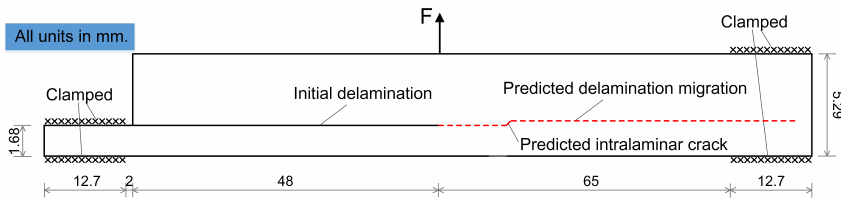
Figure 7. Test setup in delamination migration. Table 1. Elastic properties of the CFRP